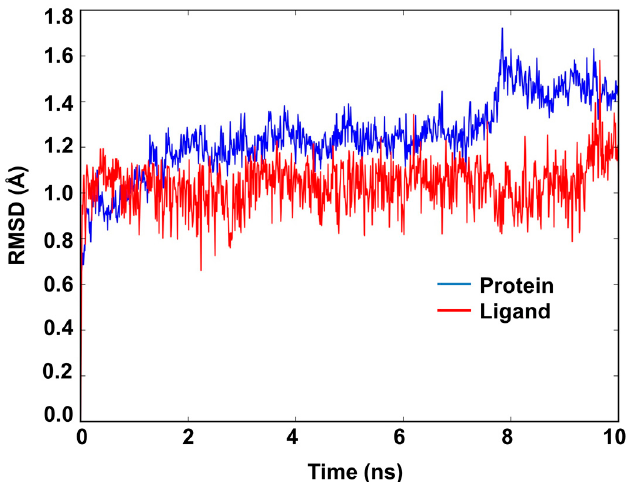
Figure 7. Root Mean Square Deviation (RMSD) plot of atom locations vs. simulation time of MAO-B (protein) and acacetin 7-methyl ether (ligand) for the molecular dynamics (MD) simulation of their interaction complex.